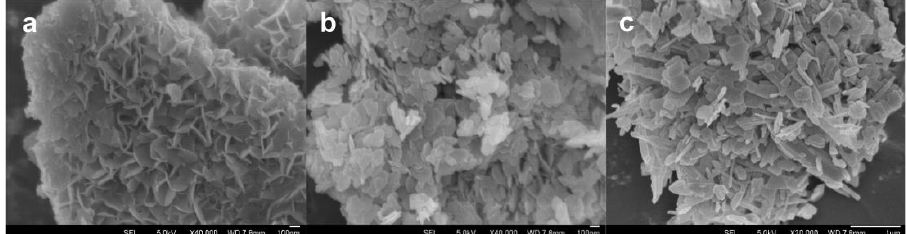
Figure 3. Scanning electron microscopy images of α -Zr-(NH 4 PO 4 ) 2 ·H 2 O prepared in the absence of